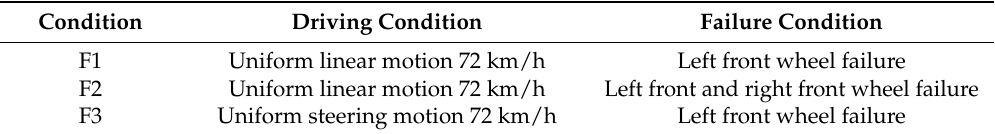
Table 5. Special condition of simulation